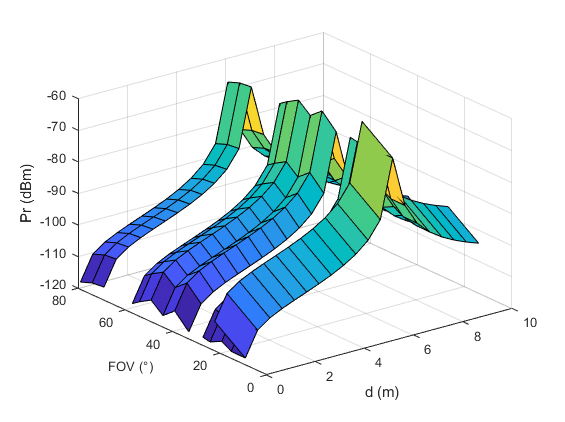
Fig. 4. The distribution of Power received vs. distance for different FOVs values